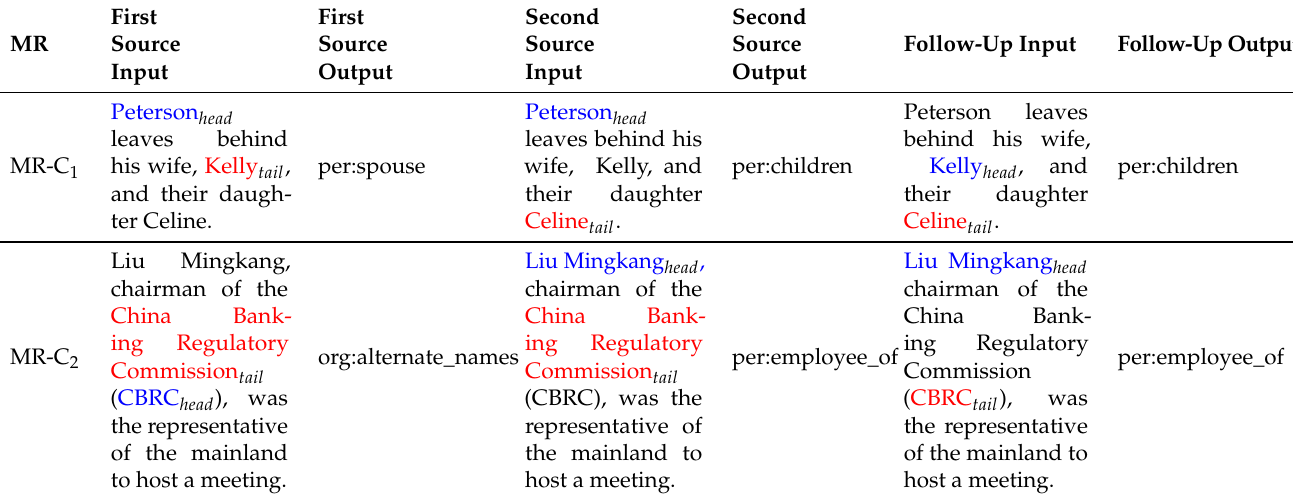
Table 3. Sample MGs of MRs with the combination